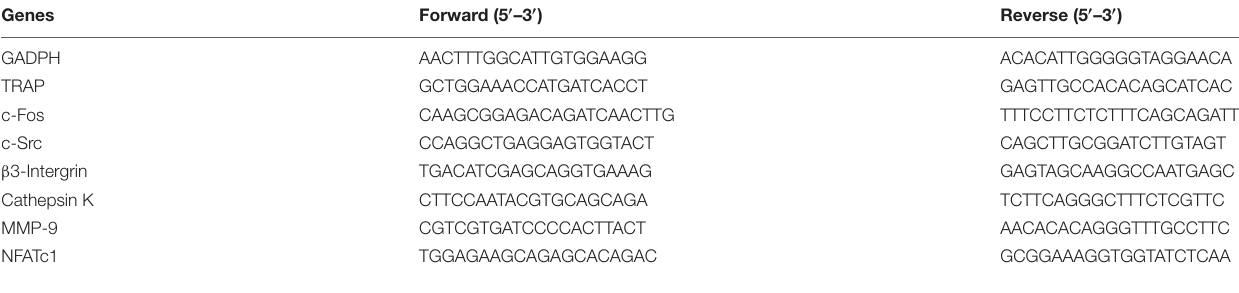
TABLE 2 | Effect of Pu-erh tea extract (PTE) on body weight (g) in OVX rats # . Time (week)